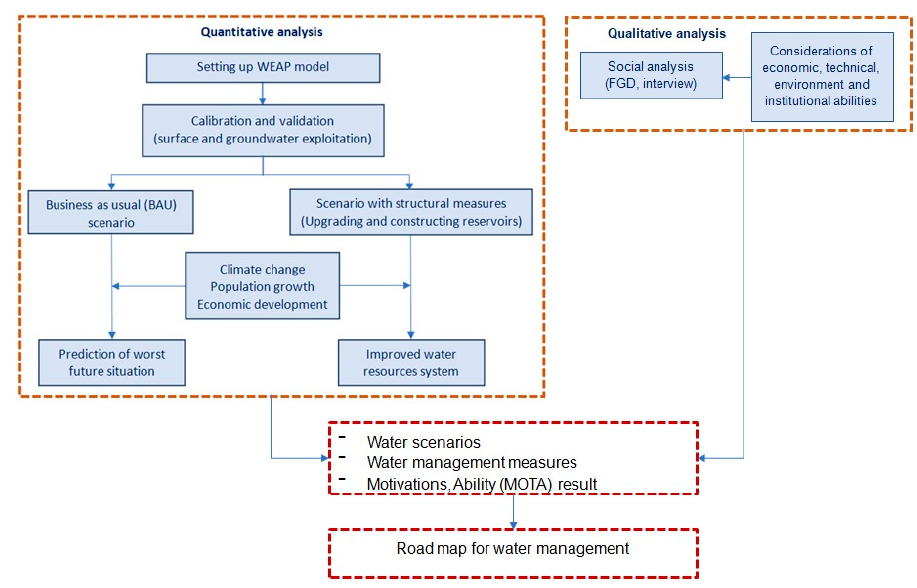
Figure 3. Study framework.